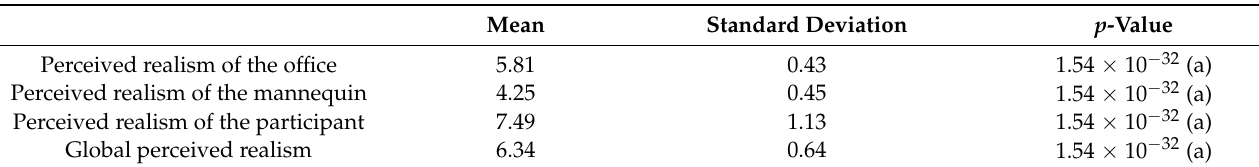
Table 3. Realism perceived by teachers.